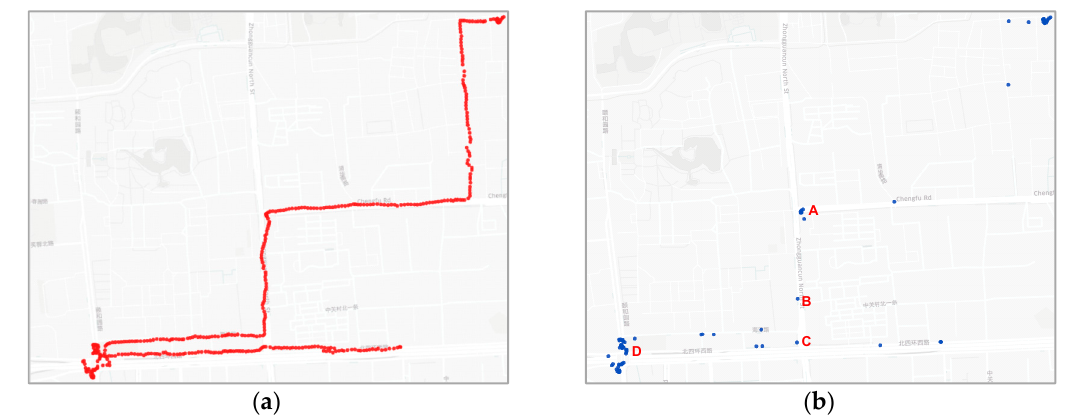
Figure 3. Location extraction results of: ( a ) density-based spatial clustering of applications with noise (DBSCAN) and ( b ) dynamic DBSCAN (D-DBSCAN) algorithms.